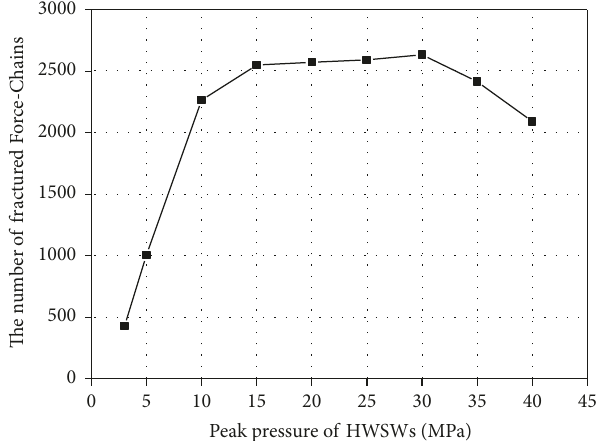
Figure 9: Number of fractured Force-Chains between two particles in PFC fracturing models under a single-impact for each of the nine groups (variable peak pressure).